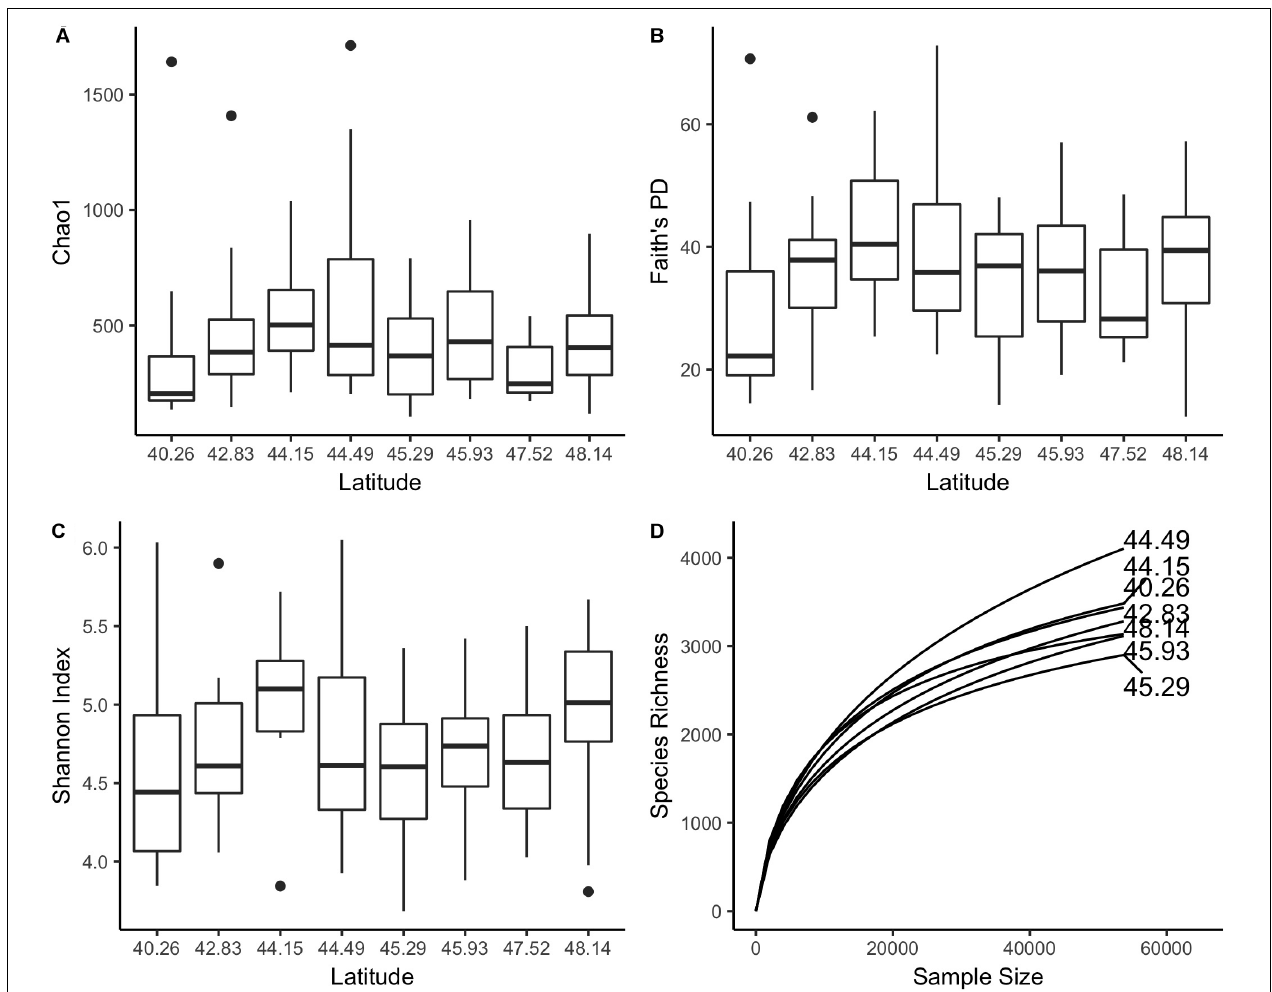
FIGURE 5 | We did not find an association between latitude and (A) Chao1, (B) Faith’s PD, or (C) Shannon Index values using a Spearman correlation or Kruskal–Wallis test. (D) A rarefaction curve of samples aggregated by site ( n = 14 or 15) provides estimates of the total number of OTUs observed at each site. At a depth of 50,000 observations, a median of 3,204 OTUs were